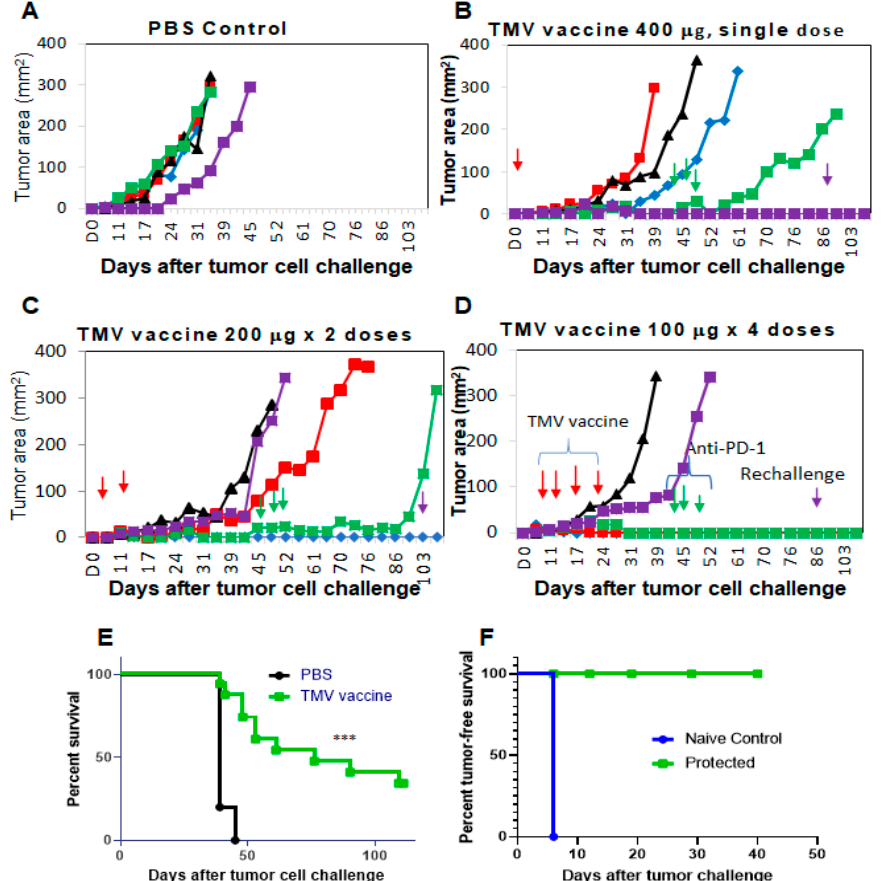
Figure 2. Multiple doses of TMV vaccine is more effective than single dose of bulk TMV vaccine in inhibiting SCC VII tumor growth: C3H / HeJ mice ( n = 5 / group) were injected with 5 × 10 4 SCC VII cells s.c. and TMV vaccine (red arrows, 100, 200, or 400 µ g) injected after three days. ( B – D ) Total amount of TMV vaccine per mouse is 400 µ g (one time on d3 ( B ), two times on d3 and d10 ( C ) or every week for four doses (d3, d10, d17, and d24 ( D )). While the tumors have reached IACUC end point in